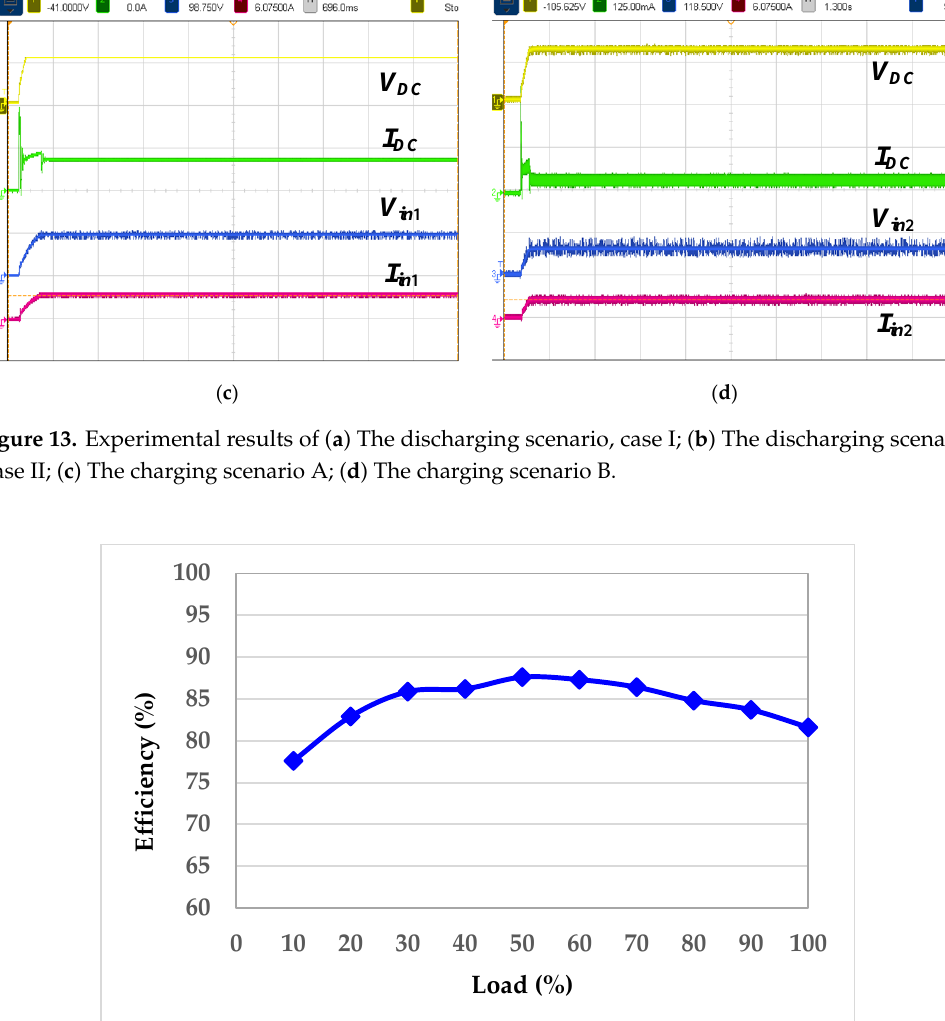
Figure 14. Experimental efficiency measurement of the proposed MIC circuit.